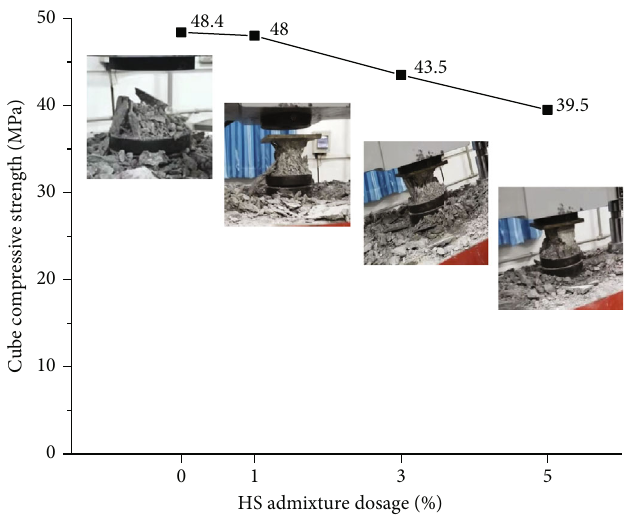
Figure 5: Results of the cube compressive strength test.